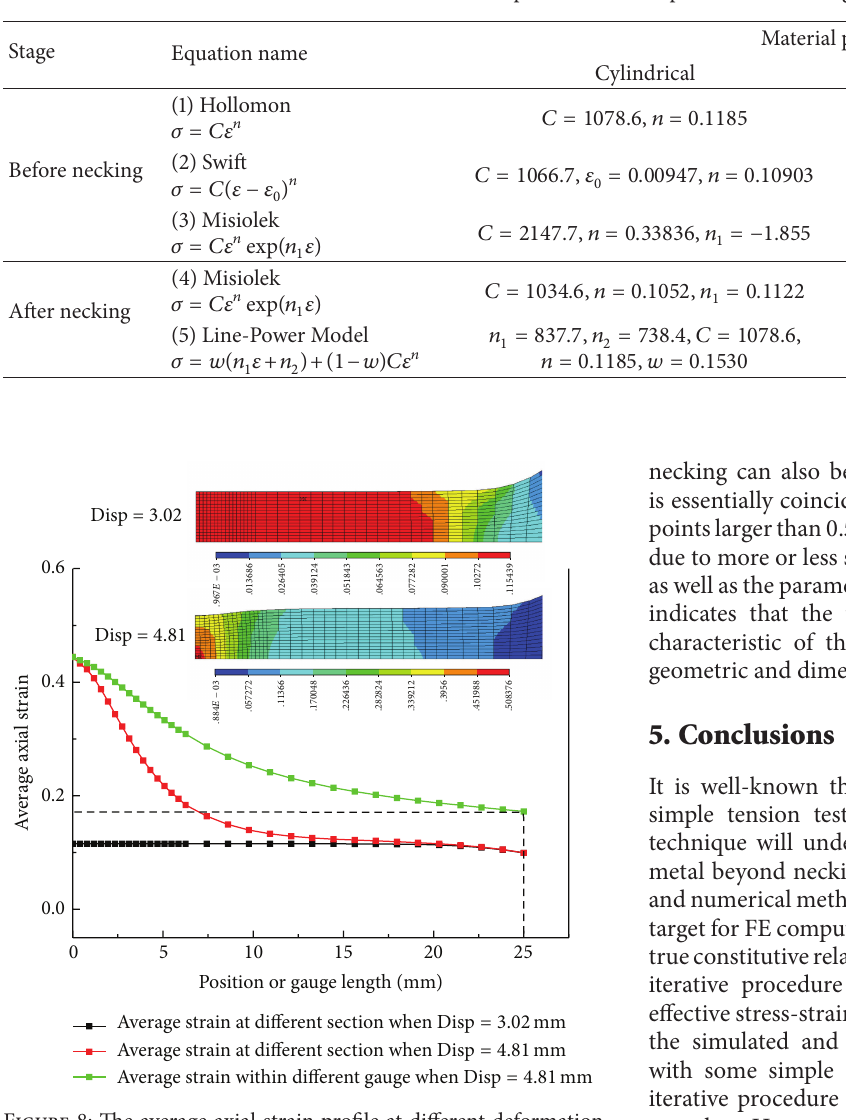
Figure 8: The average axial strain profile at different deformation stages and the average axial strain within different gauge